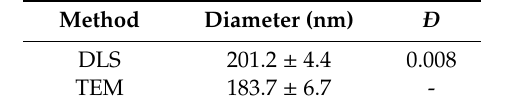
Figure 8. ( a , b ) TEM images of the inimer-containing particles. Table 2. Average hydrodynamic diameter of particles measured by means of DLS and